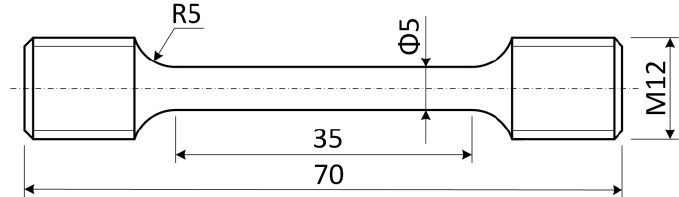
Figure 2. Dimension of tensile specimen.